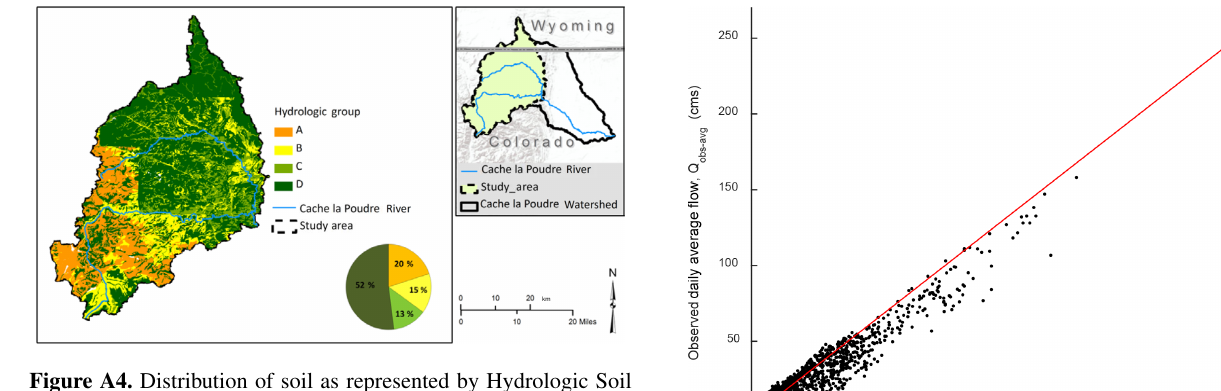
Figure A4. Distribution of soil as represented by Hydrologic Soil Groups A–D within the study watershed based on the USDA’s gSSURGO database.